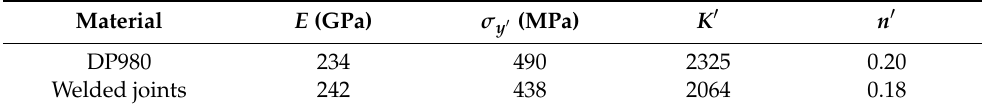
Figure 11. Cyclic stress-strain curves vs. monotonic tensile stress-strain curves. ( a ) DP980 steel sheet and ( b ) welded joints. Table 4. Cyclic mechanical properties obtained from